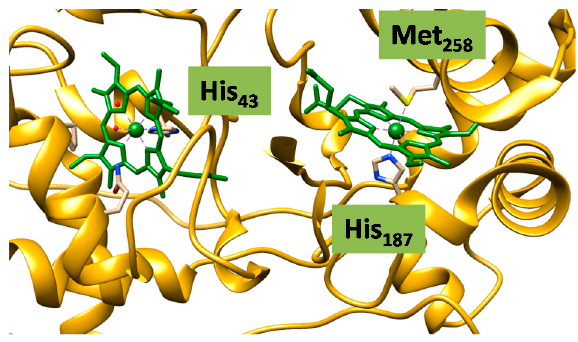
Figure 3. Extract of the di-heme cytochrome c peroxidase structure as taken from the 1IQC pdb file.